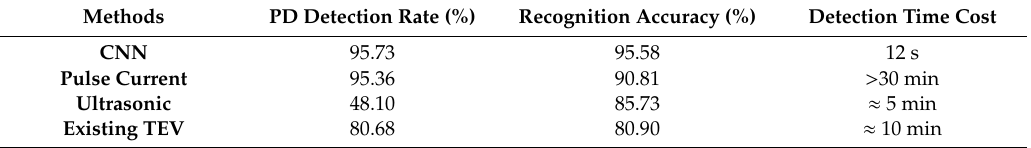
Table 2. Results comparison between Convolutional Neural Networks (CNN) and traditional